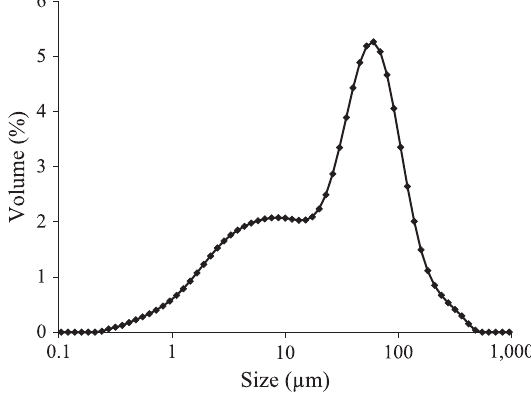
Fig. 4 Particle size distribution of the cyclone product.